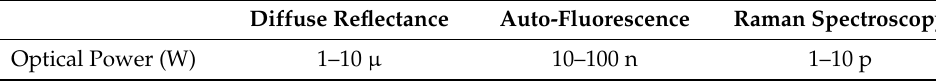
Table 1. Optical phenomena and optical powers.